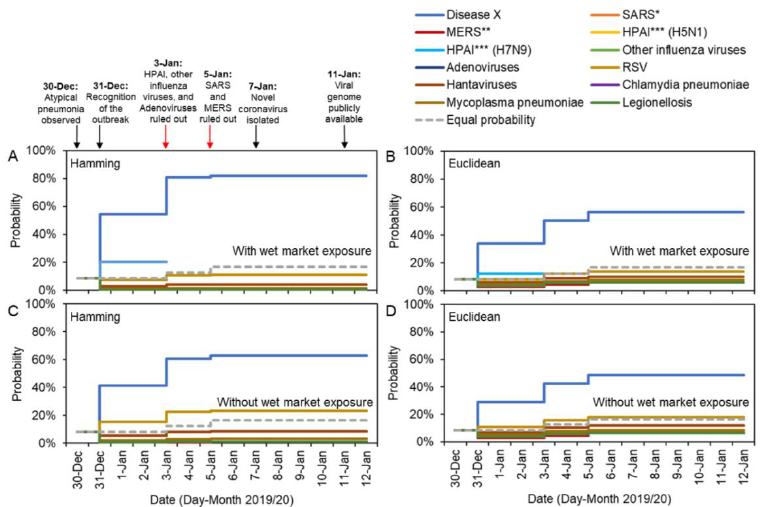
Figure 1. Real-time estimation of the probability that the ongoing pneumonia outbreak is driven by each candidate pathogen, given available information on different days. The probability that the outbreak is due to an unknown pathogen (Disease X) increases as more information becomes available, for two reasons: (i) the current outbreak can be seen to exhibit characteristics that are not similar to those observed in previous outbreaks, and; (ii) previously observed pathogens are ruled out by laboratory test results. Arrows indicate new information available on each date. Results are shown for different metrics describing the distance between characteristics of the ongoing outbreak and each candidate pathogen, and either including or excluding initial exposure information for the current outbreak (i.e., worked at/visited a wet market), specifically: ( A ) Hamming distance (the sum of squares difference between the entries in the columns of Table 1 corresponding to the ongoing outbreak and the candidate pathogen considered) with wet market exposure; ( B ) Euclidean distance (the square root of the Hamming distance) with wet market exposure; ( C ) Hamming distance without wet market exposure; ( D ) Euclidean distance without wet market exposure. Dashed grey lines show the probability for every pathogen (including Disease X) if the only information included is the ruling out of different pathogens through laboratory tests (i.e., a probability of 1/(1 + number of candidate pathogens remaining on that day)). Note that the probability corresponding to different pathogens can be identical, for example, severe acute respiratory syndrome (SARS) and Mycoplasma pneumoniae were assessing as being equally likely as the causative pathogen from 30 December to 4 January, and Legionellosis and Chlamydia pneumoniae had equal probability from 30 December to 12 January (Details in Supplementary Material S1).